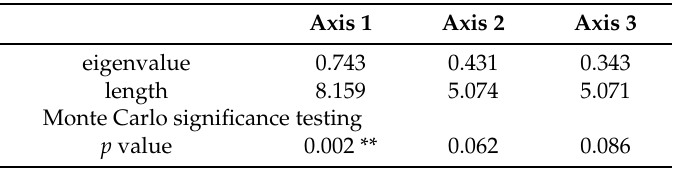
Table 1. Results of the length and the eigenvalues with each axis in detrended correspondence analysis (DCA).